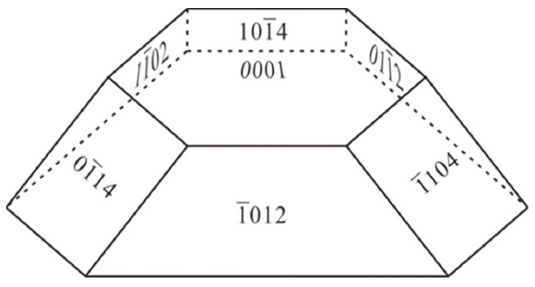
Figure 4. Schematic diagram and crystal plane indices for (I), (II), (III), and (IV).